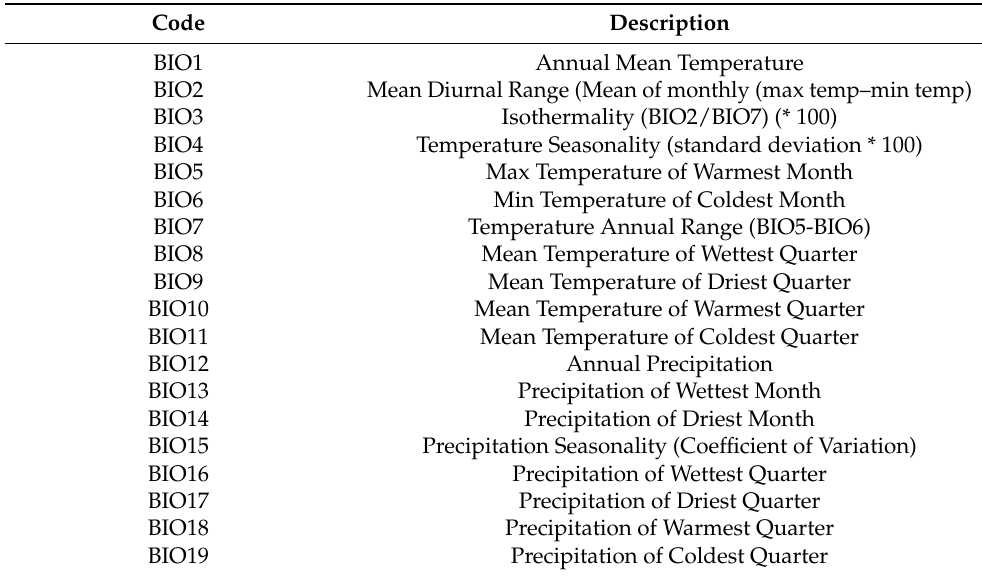
Table 1. Introduction of 19 bioclimate